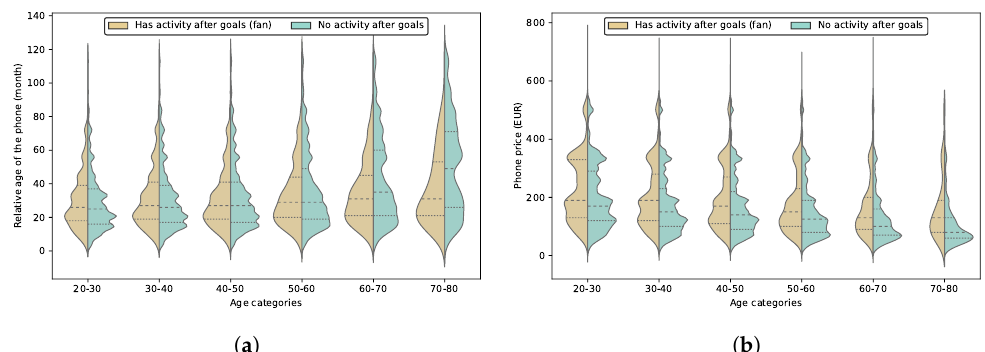
Figure 15. Mobile phone relative age ( a ) and the price distributions ( b ) in different age categories, comparing the fans who had activity right after any two of the Hungarian goals and the rest of the SIM